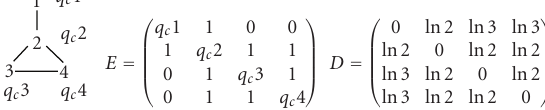
Figure 1: Example of the matrices E and D